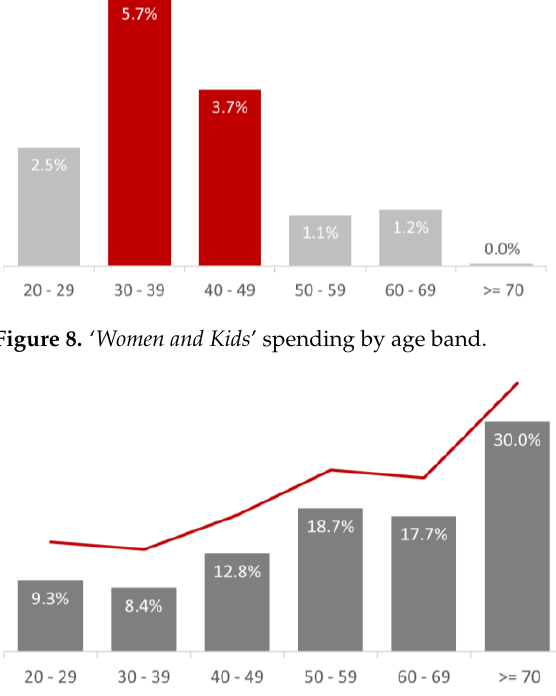
Figure 8. ‘ Women and Kids ’ spending by age band . Figure 9. ‘ Specialists ’ spending by age